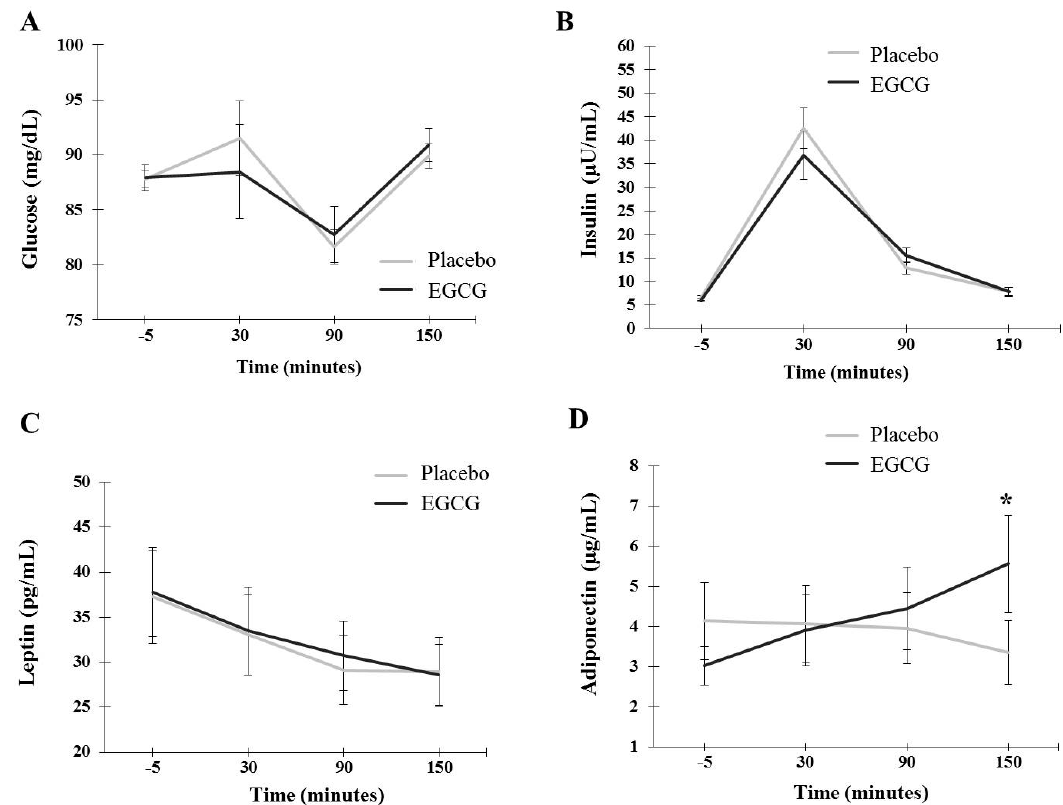
Figure 5. Plasma concentrations of glucose ( A ), insulin ( B ), leptin ( C ) and adiponectin ( D ). Plasma concentrations of glucose, insulin, leptin and adiponectin between treatments (placebo × EGCG) were assessed using the two-way ANOVA (adjusted to individual variation). Values are mean ± SEM. Differences found are highlighted with * ( p < 0.05).